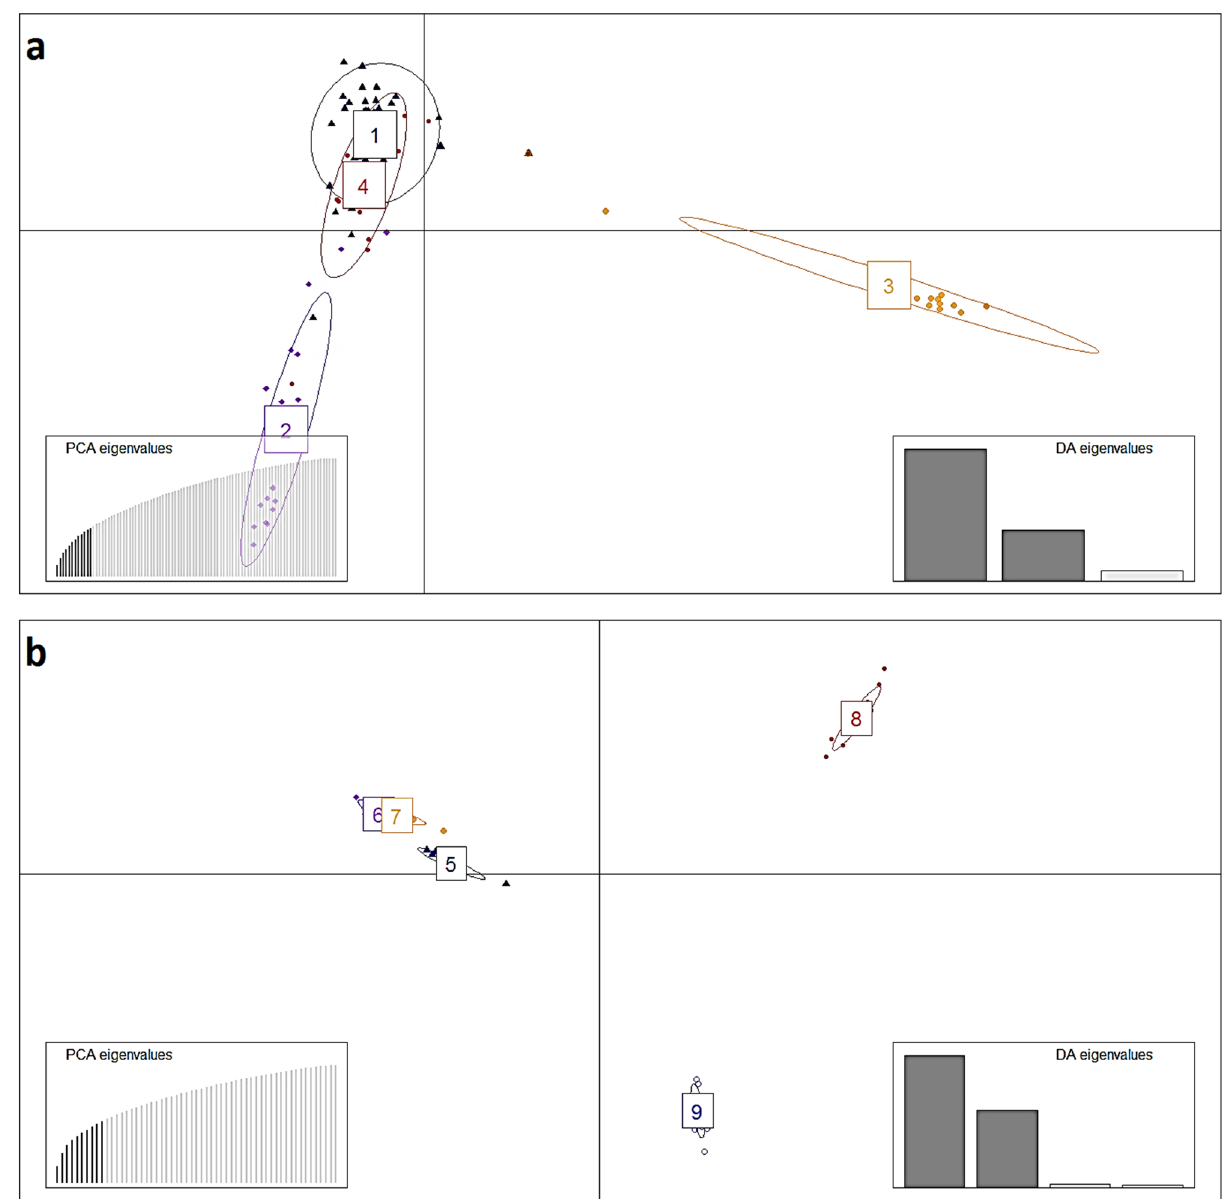
Figure 2. DAPC analysis from hatcheries of pacu (Hatchery 1–4) ( a ) and tambaqui (Hatchery 5–9) ( b ) to demonstrate the genetic structure using the SNPs. DAPC was performed adopting an optimum number of principal components (PC = 10) calculated using the α-score function of the Adegenet